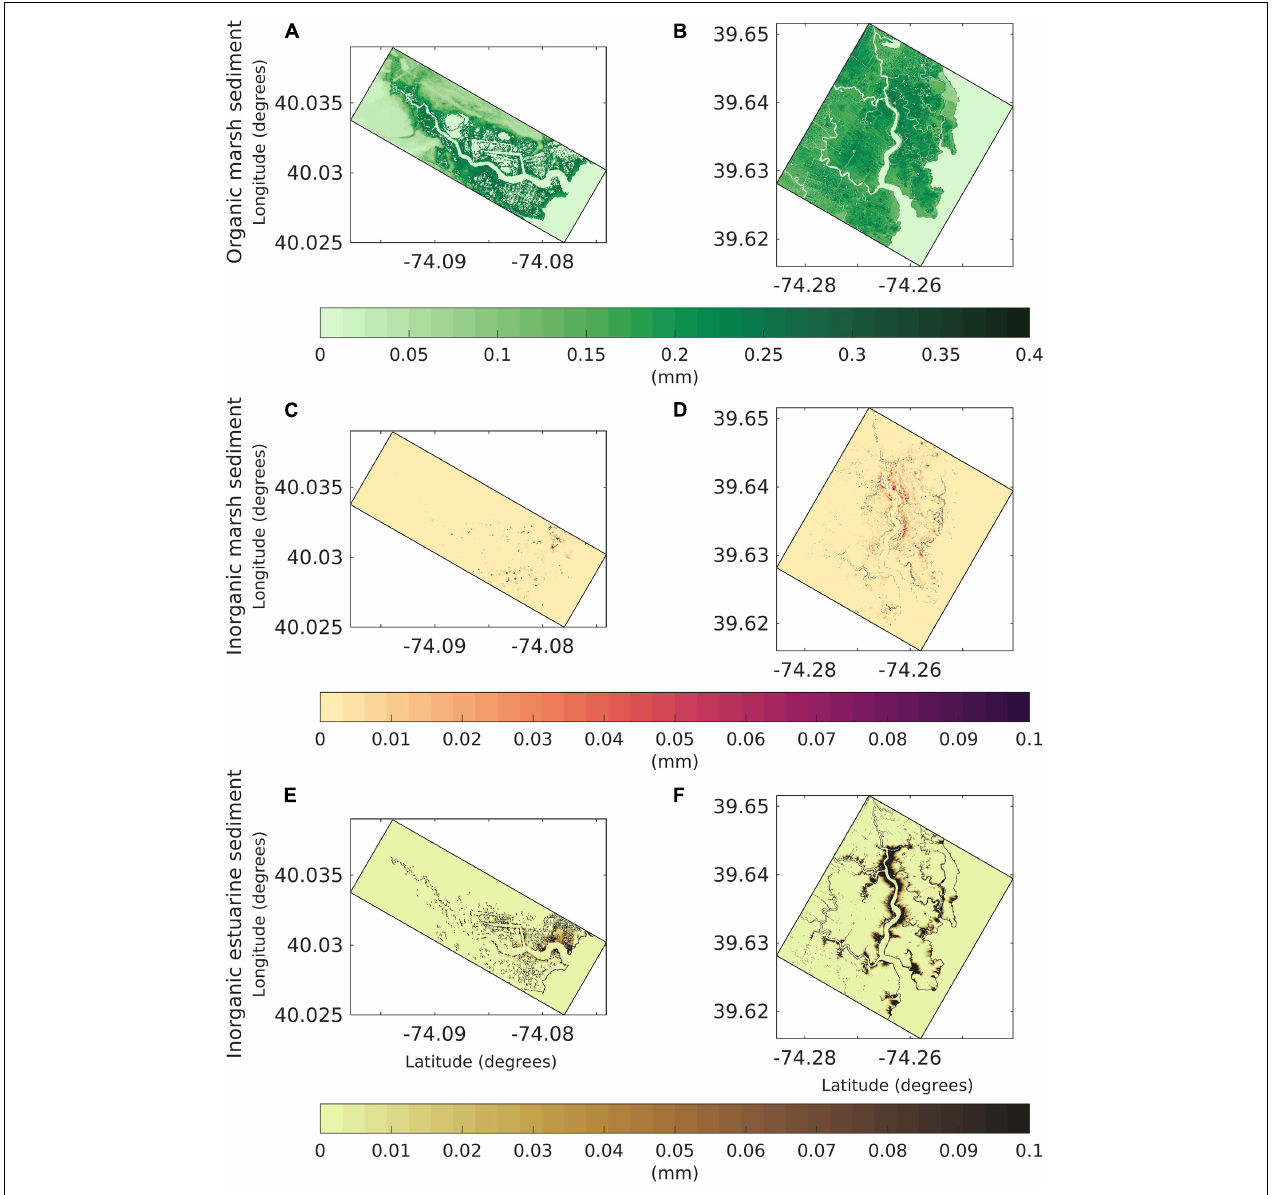
FIGURE 12 | Distribution maps of the modeled sediment deposition by type for both the Reedy Creek (RC) and Dinner Creek (DC) marsh complexes at the end of the simulation. Organic marsh sediment depth for the (A) RC and (B) DC domain. Inorganic marsh sediment depth for the (C) RC domain and (D) DC domain. Inorganic estuarine sediment for the (E) RC domain and, (F) DC domain. The colorbar is common to both domains for each sediment